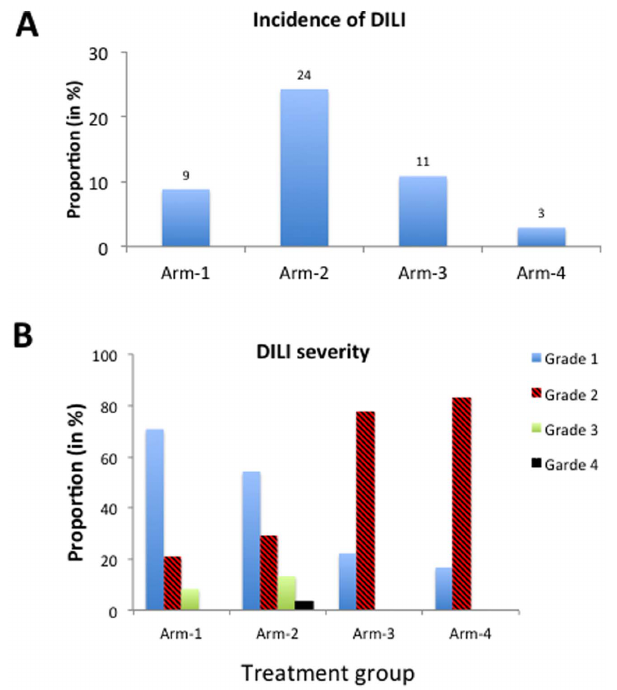
Figure 1. Comparison of incidence (Figure 1A) and severity grade of DILI in study participants stratified by treatment groups: HIV patients without TB co-infection (Arm-1) treated with efavirenz based HAART alone, TB-HIV co-infected pa- tients with CD4 count # 200 cells/ m L treated with concomitant anti-TB and HAART therapy (Arm-2), TB-HIV co-infected patients with CD4 count . 200 cells/ m L treated with anti-TB therapy alone (Arm-3) and TB patients without HIV co- infection treated anti-TB therapy alone (Arm-4). Figure 1B indicates severity grade distribution among the total 159 DILI cases.